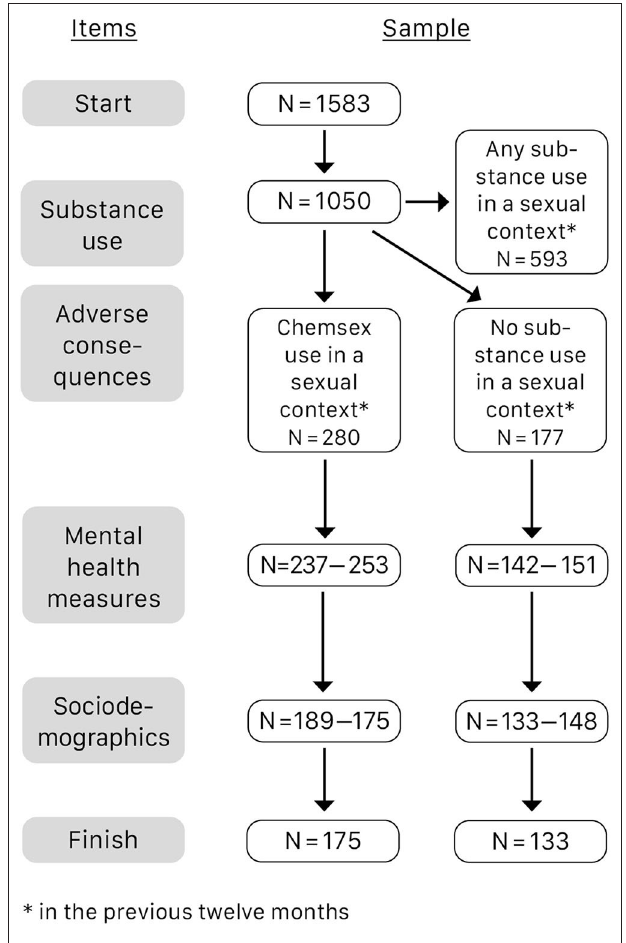
FIGURE 1 | Development of participants’ numbers in the course of the survey.